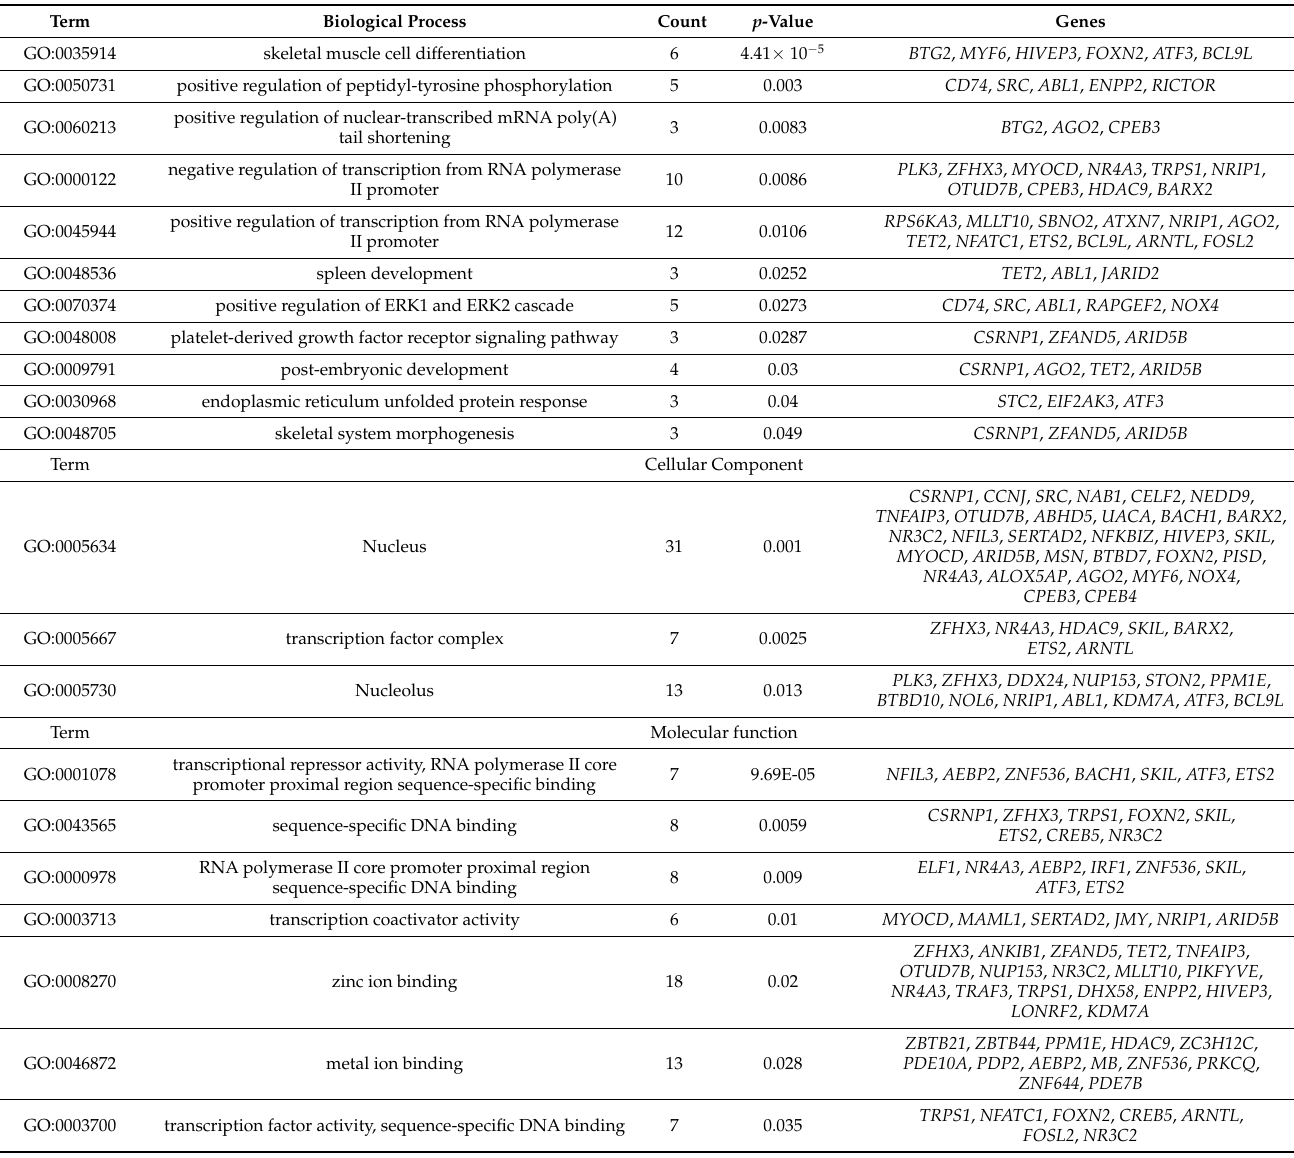
Table 5. Ontology analysis of down-regulated genes in HFE compared to LFE